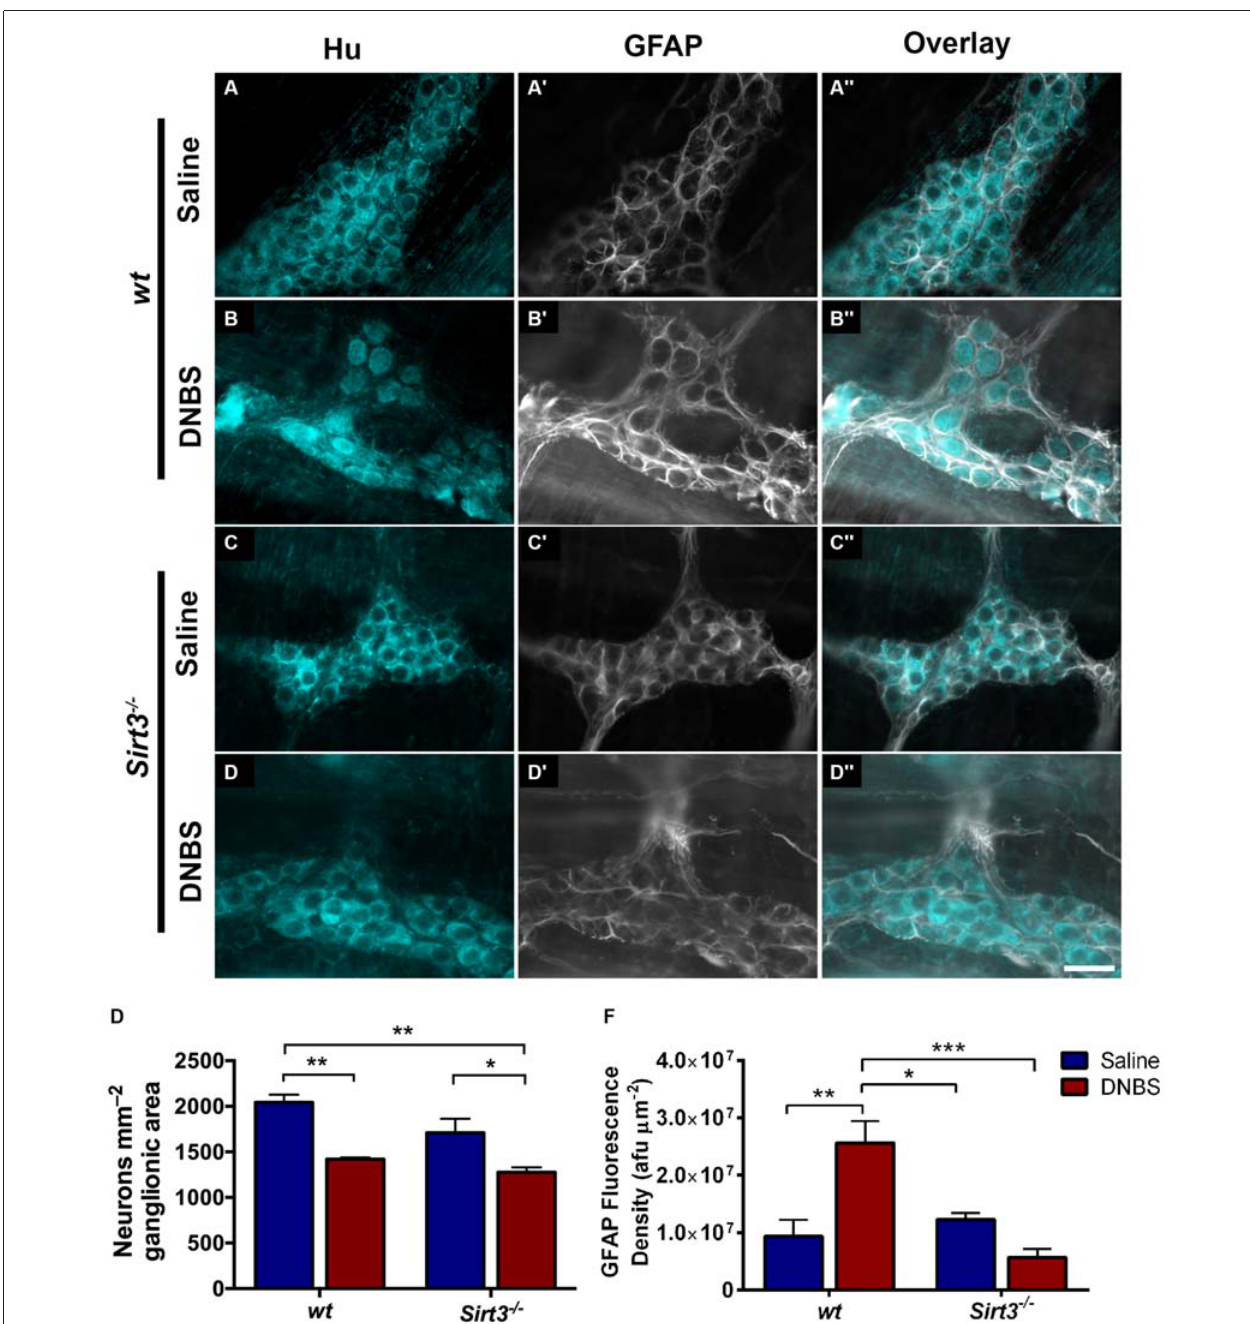
FIGURE 6 | Enteric neuron survival and glial reactivity in healthy and inflamed wt and Sirt3 − / − mice. (A–D”) show dual-label fluorescence immunohistochemistry for HuC/D (cyan, A–D ) and GFAP (grayscale, A’–D’ ) in myenteric ganglia from saline- (A–A”, C–C”) or DNBS-treated (B–B”, D–D”) wt (A–B”) or Sirt3 − / − (C–D”) mice. Overlays are shown in (A”–D”) . Scale bar in D” = 50 µ m and applies to all images. (E) Quantification of myenteric neuron packing density. (F) Quantification of ganglionic GFAP fluorescence density (afu/ µ m 2 ). n = 3–5 animals per group, ∗ P < 0.05, ∗∗ P < 0.01, ∗∗∗ P < 0.001, 2-way ANOVA.